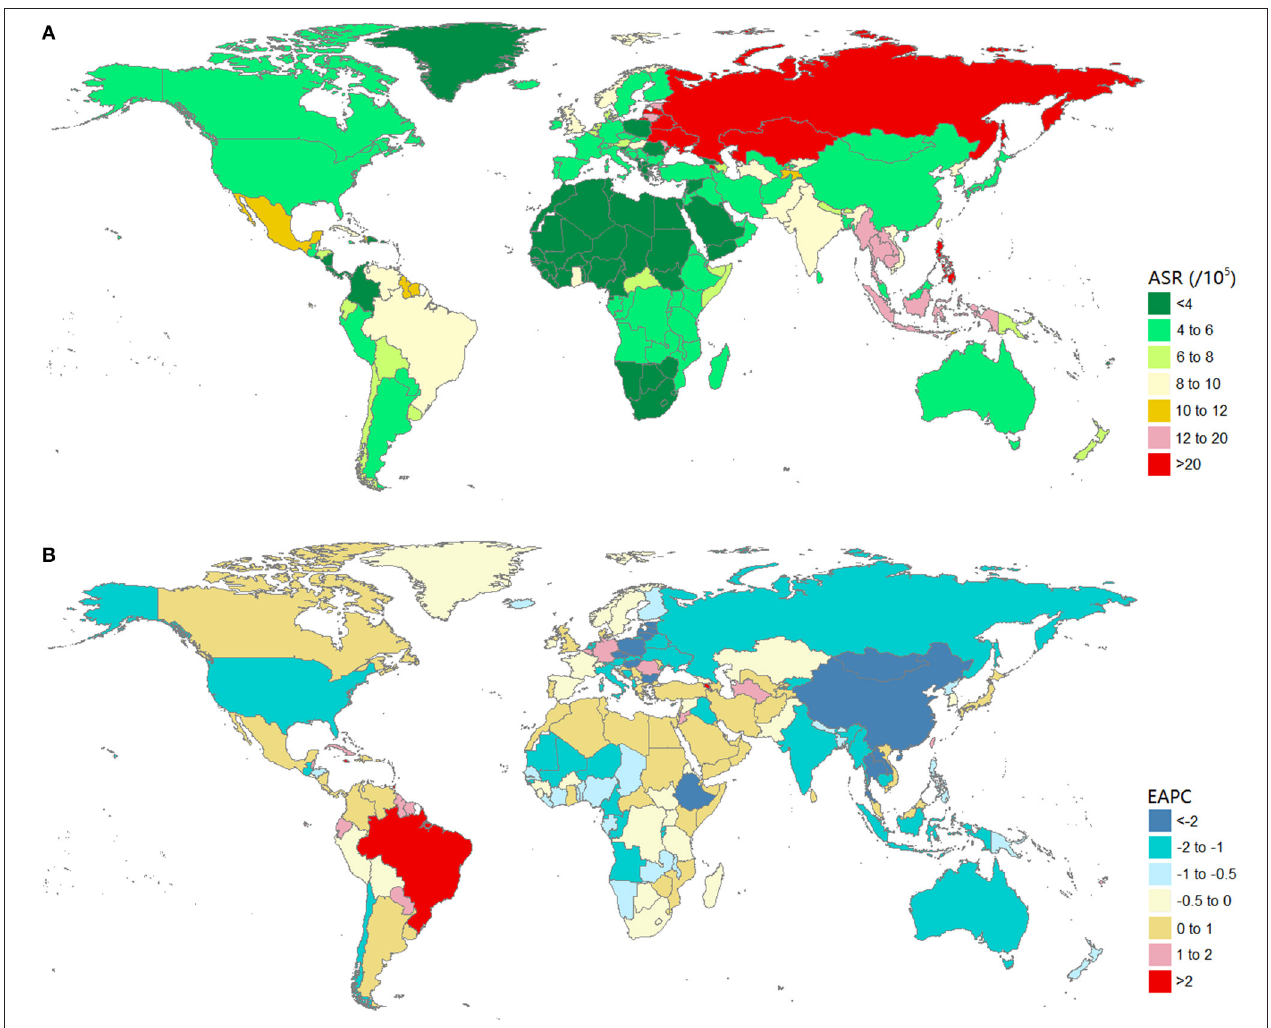
FIGURE 4 | The global burden of urolithiasis in 204 countries or territories. (A) The age-standardized DALYs rate of urolithiasis in 2019. (B) The EAPC of age-standardized DALYs rate of urolithiasis from 1990 to 2019. Countries with an extreme number of cases/evolution were annotated. DALYs, disability-adjusted life years; EAPC, estimated annual percentage